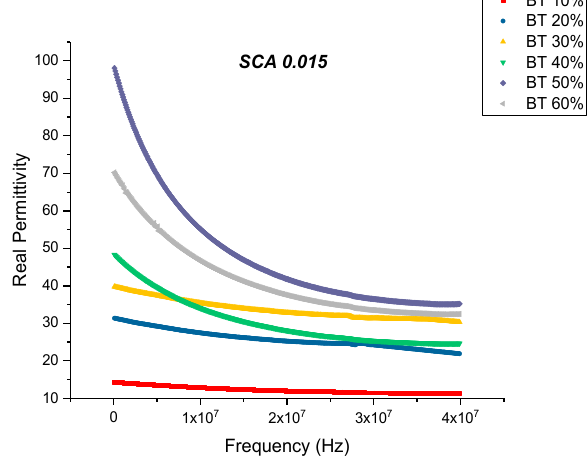
Figure 9. The real permittivity of the BaTiO 3 -epoxy composite that were fabricated using BaTiO 3 nanoparticles which were surface modified using 0.015 SCA is plotted as a function of frequency where the volume fraction of BaTiO 3 is varied from 0.1 to 0.6.